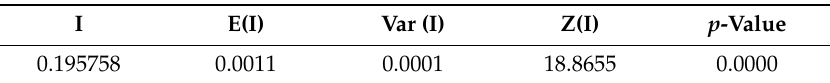
Table 5. Results of Moran’s I